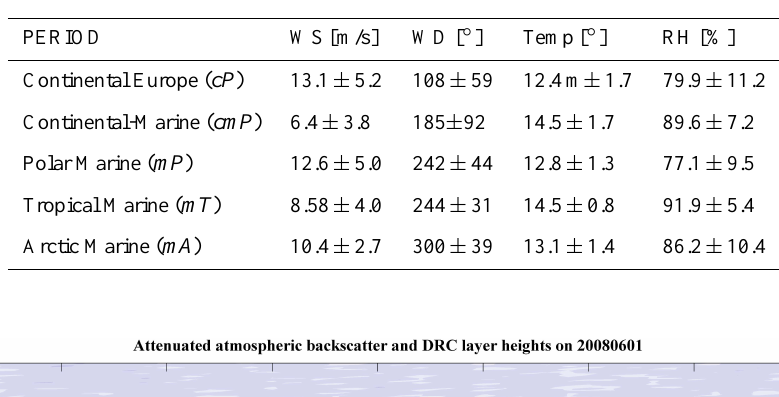
Table 2. Meteorologiacal conditions.